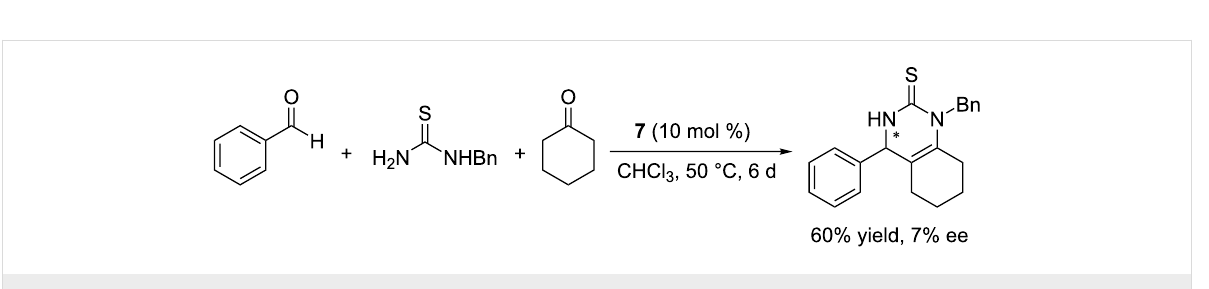
Scheme 3: Control experiment with catalyst 7 .